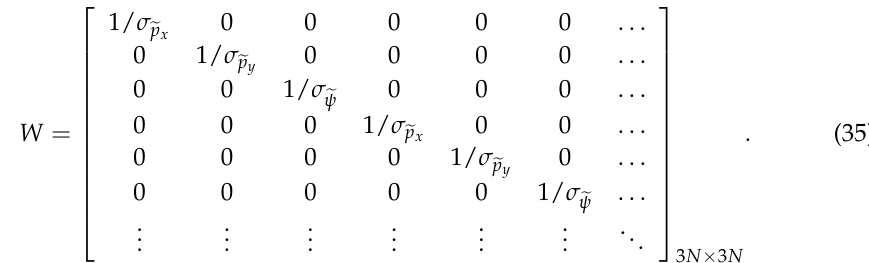
settings in the estimation (cid:101) ψ